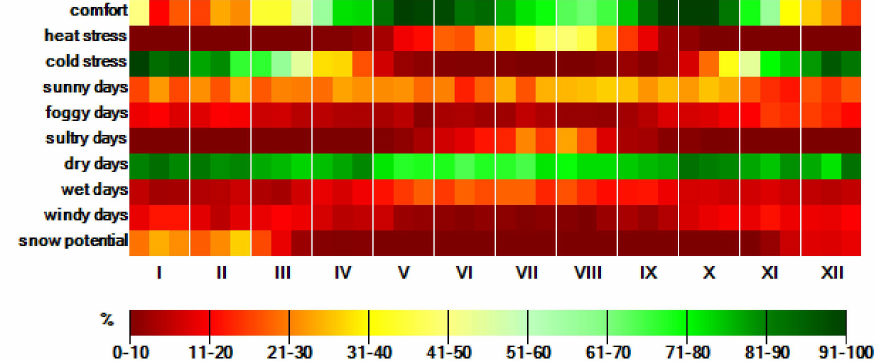
Figure 8. CTIS for Kłodzko in